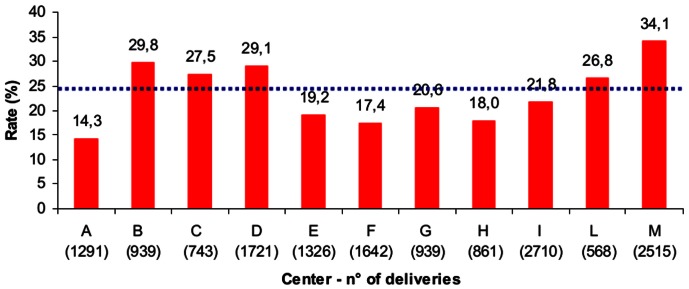
Inter-institutional caesarean delivery rates: data are presented as percentages (number of caesarean deliveries/total number of deliveries.The dot line represents the average of overall caesarean delivery rates.